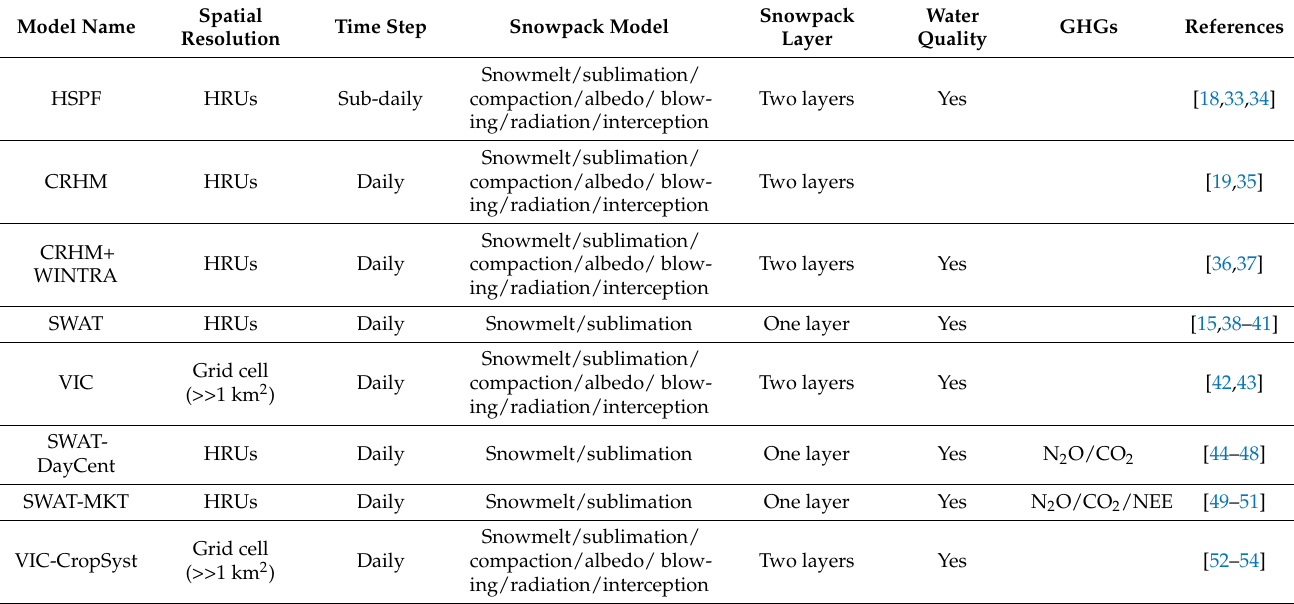
Table 1. Characteristics of watershed models in cold